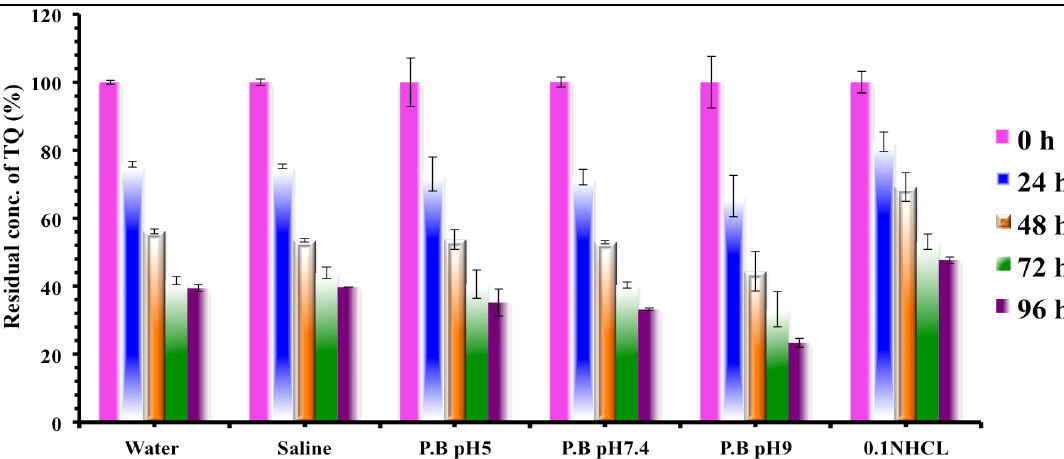
Figure 3. Residual TQ concentration in different solutions at variable time intervals of the stability study estimated by HPLC, Time in hours, (error bars represent the standard